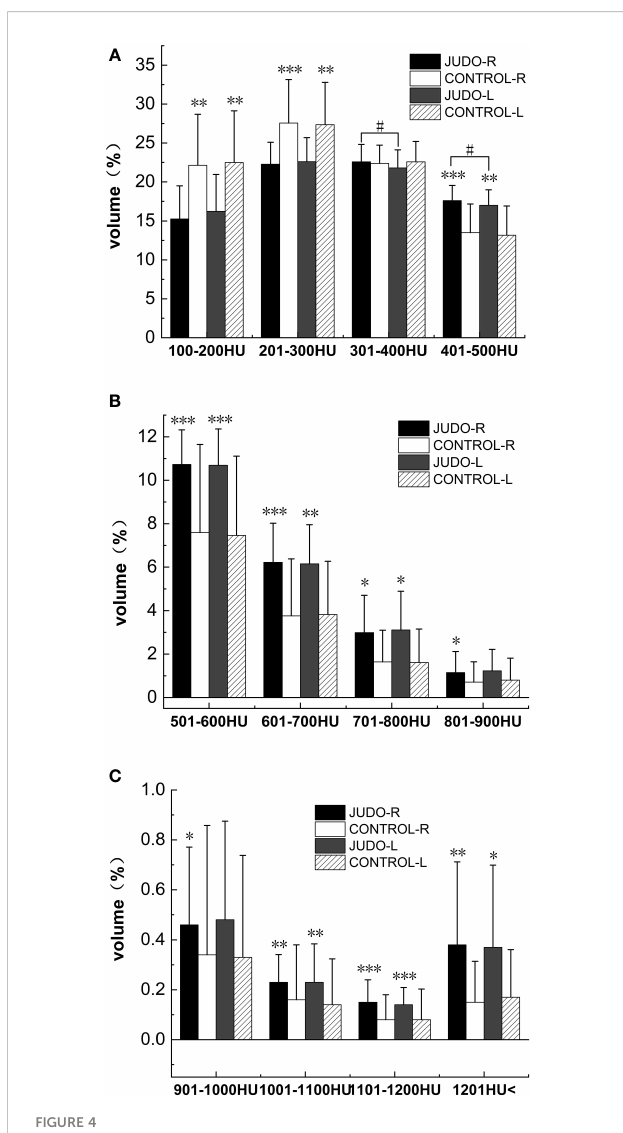
FIGURE 4 Comparison of %BTVi in the distal femur of subjects in both groups. (A) shows bone tissue volumes for low bone density in judo and control subjects; (B) shows bone tissue volumes for moderate bone density in judo and control subjects; (C) shows bone tissue volumes for high bone density in judo and control subjects (***, ** and * indicate statistically signi fi cant P -values of<0.001,<0.01 and<0.05, respectively, compared to control; # indicates the comparison of the judo athletes (the P -value with statistical signi fi cance